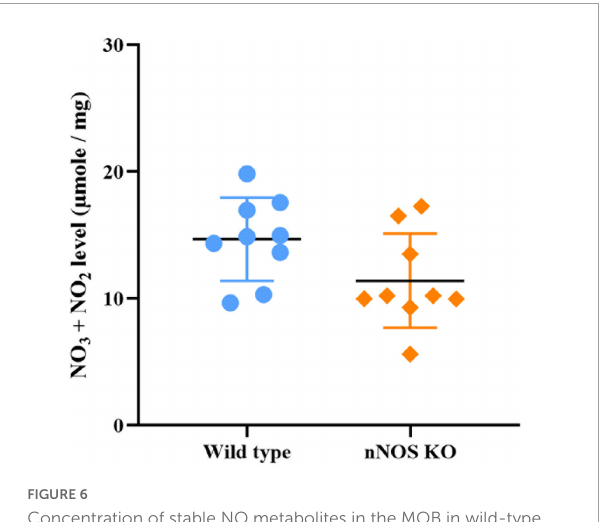
FIGURE6 Concentration of stable NO metabolites in the MOB in wild-type and nNOS-KO mice. No significant differences between experimental models were found (wild type 14.68 ± 3.55 µ mole/mg; nNOS KO 11.52 ± 3.88 µ mole/mg; p = 0.281).